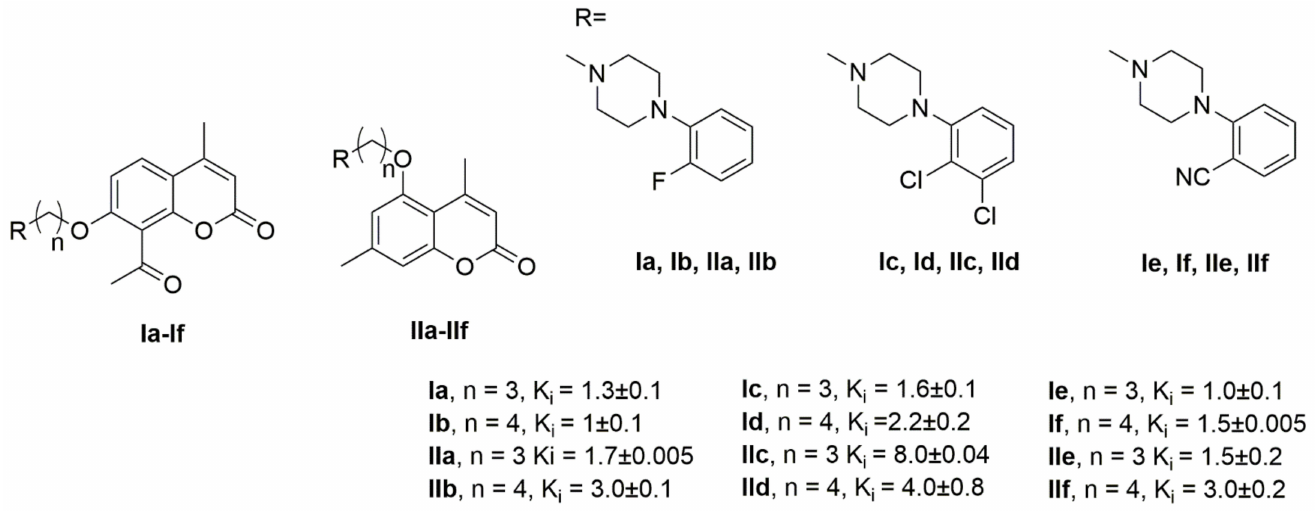
Figure 1. Selected 5-HT 1A receptor affinities of previously synthesized coumarins